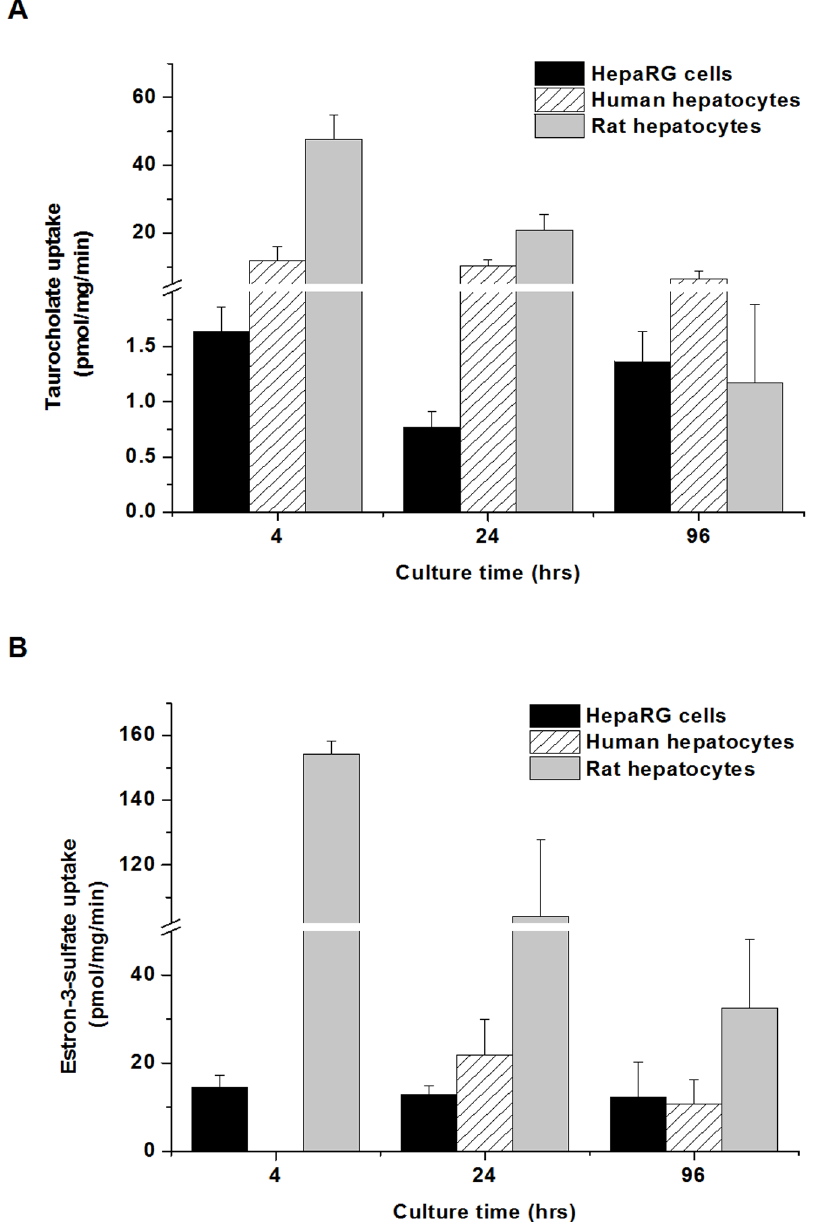
Figure 1. TC and E3S uptake in primary human and rat hepatocyte cultures and HepaRG cell cultures as a function of culture time. Cells were maintained in conventional monolayer culture. (A) Uptake of 3 H-TC or (B) 3 H-E3S (1 m M) was measured for 30 sec (hepatocytes) or 300/ 120 sec, TC/E3S, respectively (HepaRG cells) at 4, 24 and 96 h after seeding. The intracellular amount of TC or E3S was determined from the lysates of the cells as described in Methods. Values are expressed as mean 6 SD, assays were run using four wells as one set. All experiments were carried out with hepatocytes from three independent preparations.